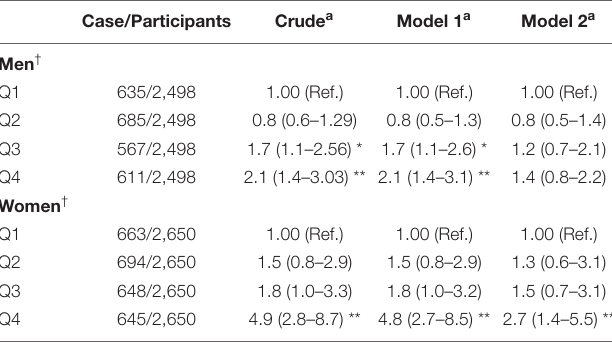
TABLE 5 | Weighted odds ratios (95% confidence intervals) for impaired fasting glucose of participants across quartiles of serum uric acid (Men = 2,498, women =